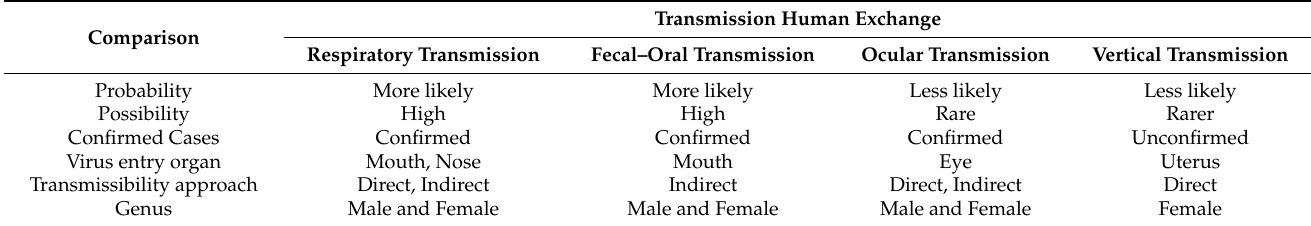
Table 2. Human exchange transmission